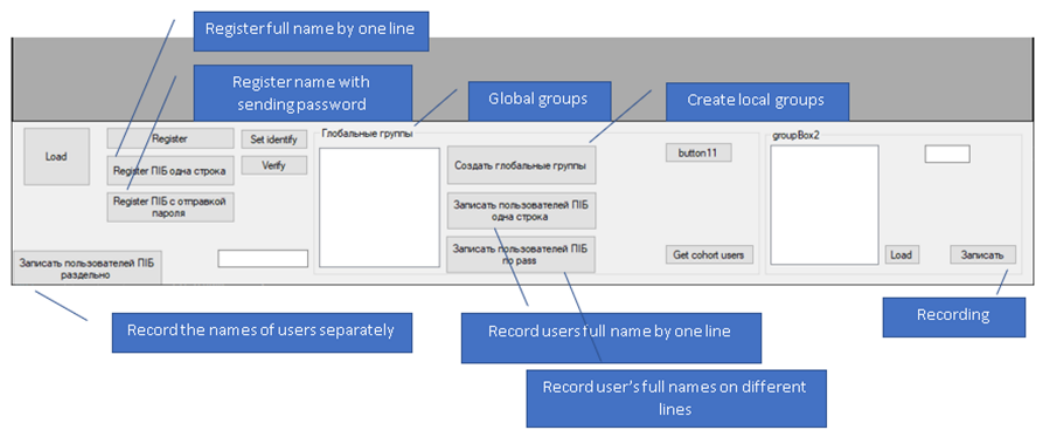
Figure 5: Application window for optimizing user registration without an ACS